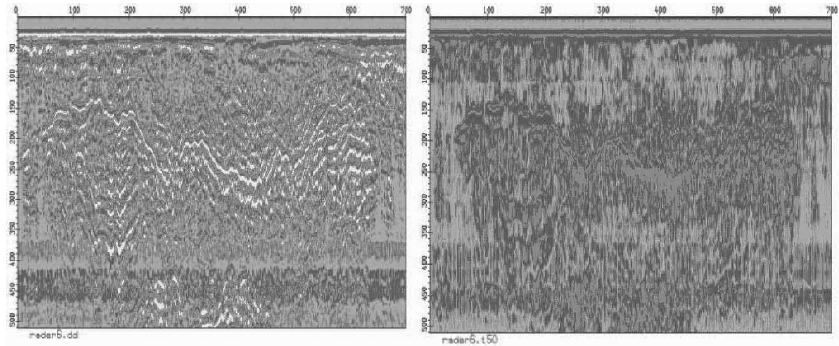
Figure 11. Subsurface radar sounding profile: before (left) and after (right) processing. Geo- logical section of some ground